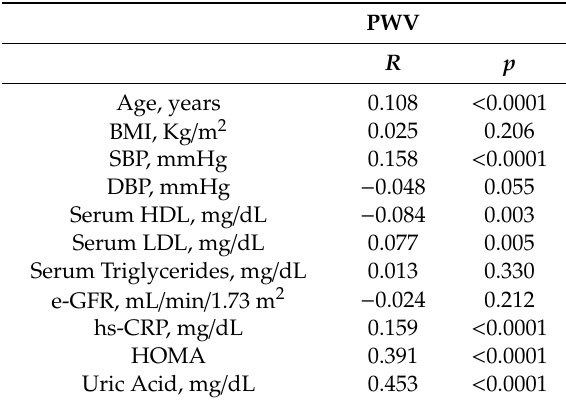
Table 3. Linear regression analysis on pulse wave velocity (PWV) as a dependent variable in the whole study population.